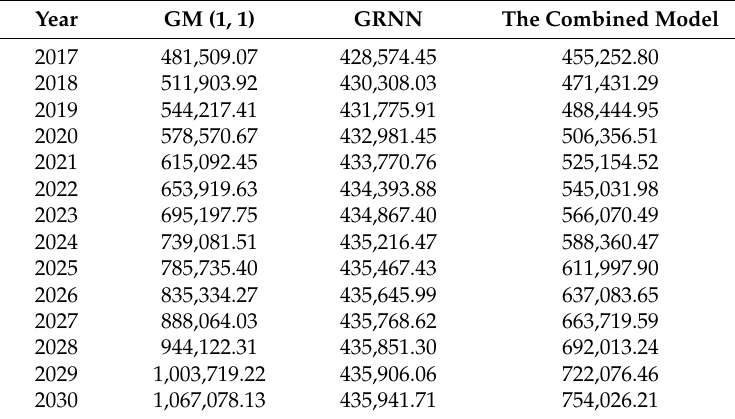
Figure 2. The forecasting process for the combined model. Table 5. Prediction of primary energy consumption. (unit: 10 4 tce).